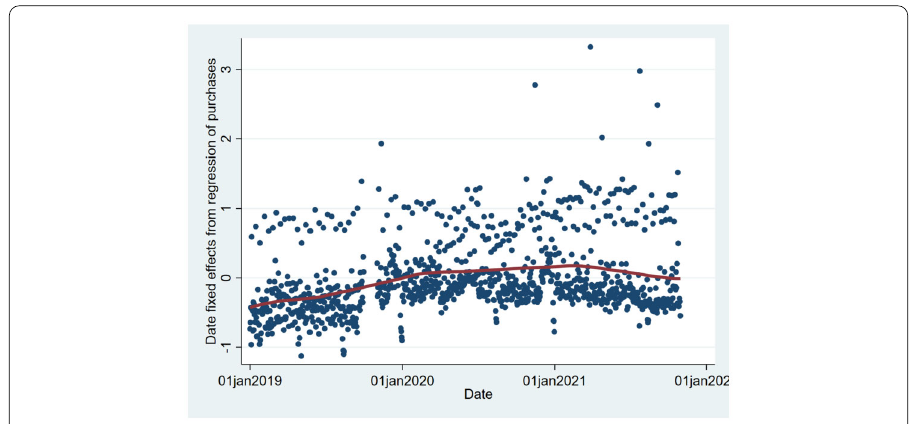
Figure 7 Date Fixed Effects from the Regression of the Purchase Amount. In this figure, the blue dots represent the date fixed effects estimated from the regressions of the purchase amount at the city level for each date, and the red line represents the fitted relationship between date fixed effects and the dates using a nonparametric local–linear kernel regression. The independent variables are the number of COVID-19 cases per 1000 persons, the declaration of a state of emergency (SoE); the number of neighboring prefectures in an SoE; the dummy variables for 1-4 weeks before and after the declaration of an SoE and a semi-SoE; and the city, date, and day-of-the-week fixed effects. The standard errors are clustered at the city level. N =